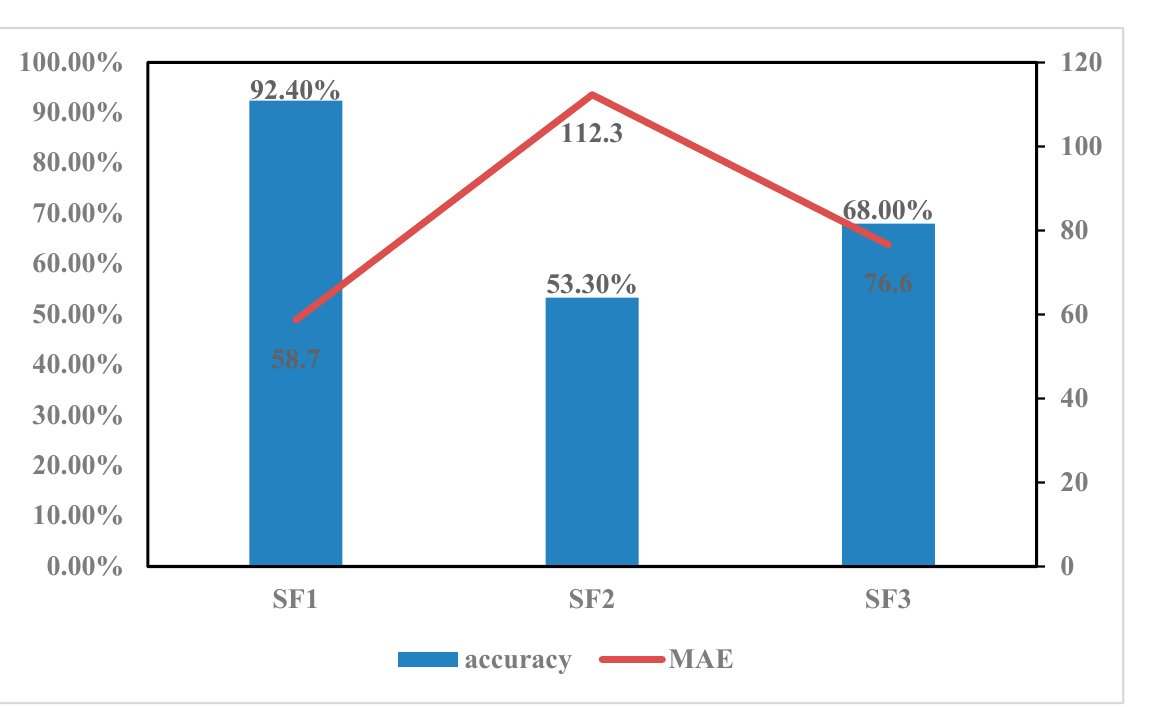
Figure 11. Experimental result graphs of different algorithm models.